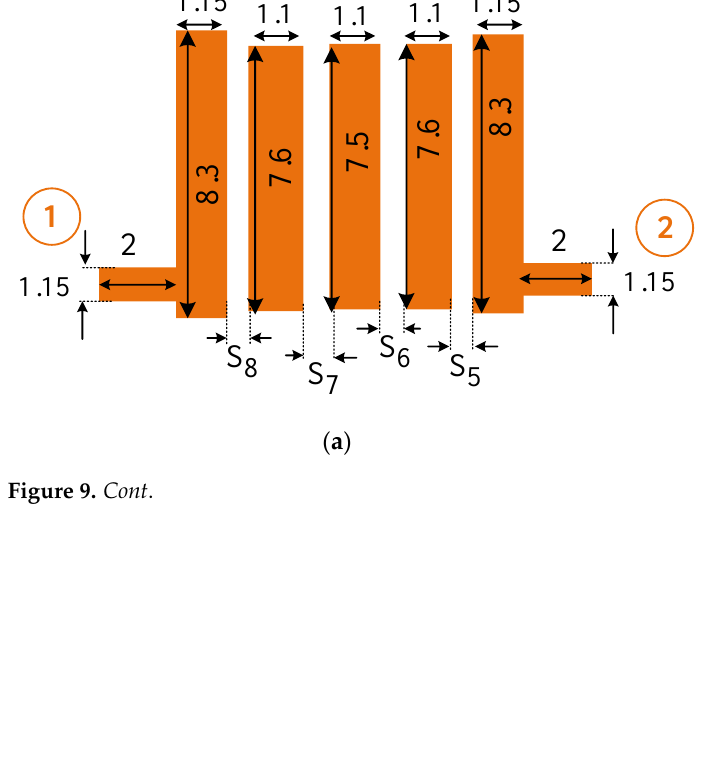
( b ) Figure 9. Designed 5.1 GHz filter. ( a ) Circuit structure, and ( b ) S-parameters simulated frequency response (dimensions are in mm). The proposed BPF correctly works at 5.1 GHz with 0.4 dB insertion loss. The pro- posed BPF has good operating bandwidth of 200 MHz from 5 to 5.2 GHz, which shows 4% FBW. Due to the reciprocal and symmetrical structure of the proposed BPF, S 11 and S 22 are similar. 5. Diplexer Configuration As mentioned in the previous section, in order to form a diplexer, two independent filters must be combined with a T-junction. The location of these two proposed filters and the T-junction are very effective at the return loss, the insertion loss, and the matching parameters. The final circuit configuration of the proposed diplexer and its frequency re- sponse are depicted in Figure 10.